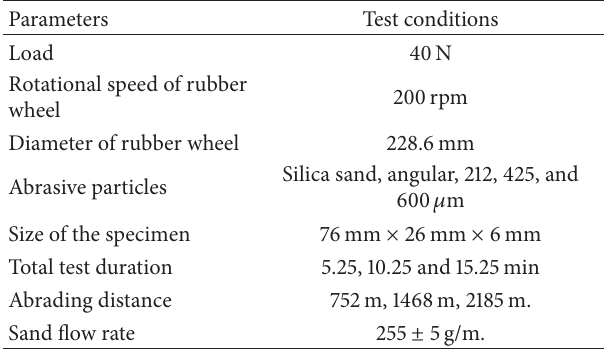
Table 4: Control factors and levels used in the three-body abrasive wear